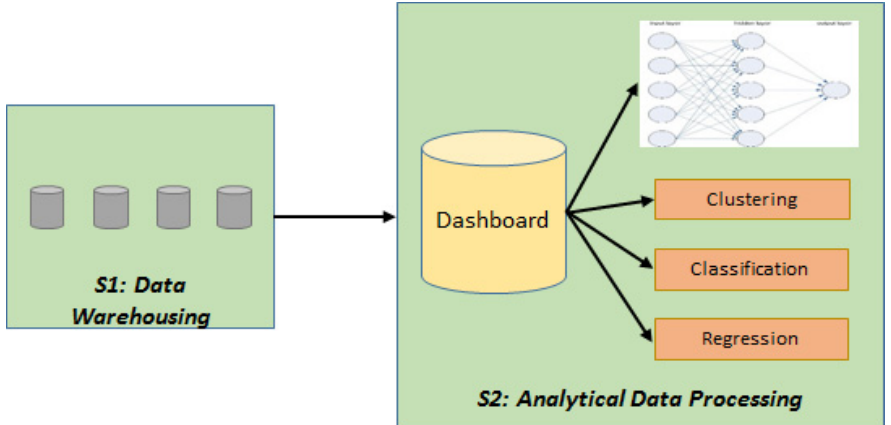
Figure 5. Analytical data processing subsystem.